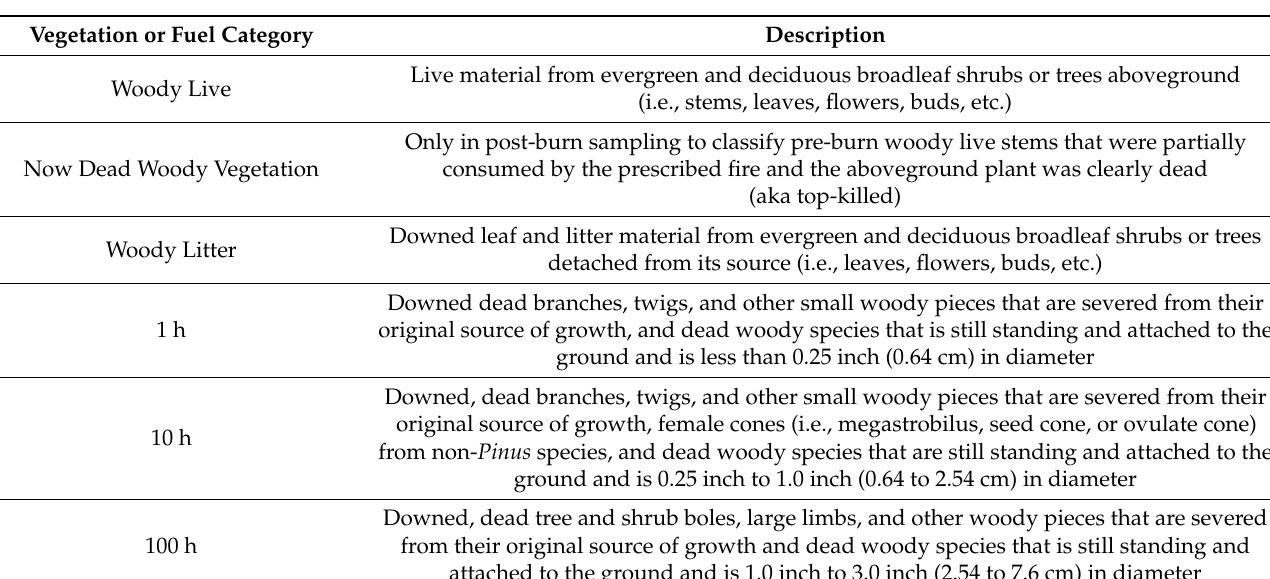
Table of original vegetation and fuel categories collected in the field and their